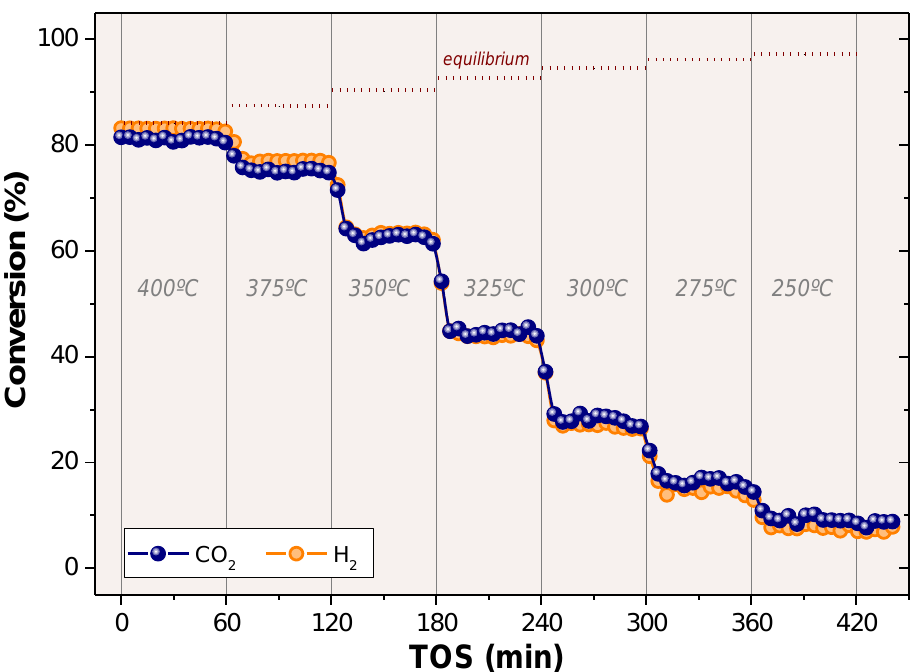
Figure 3. CO 2 and H 2 conversions as a function of temperature and time-on-stream (TOS) for ‘10Ni’ catalyst. Feeding without methane (‘W/O CH 4 ’) . Operating conditions (Table 2): q 0 = 250 STPmL · min − 1 , H 2 :CO 2 = 4:1, and WHSV = 30 × 10 3 (STPmL·g cat −1 ·h −1 ). Table 2. Experimental conditions (base value and studied range) for catalytic activity experiments. Variable (Units) Base Value Studied Range Catalyst (-) 3Ru 10Ni, 3Ru, 7.5Ni – 2.5Fe T (°C) - 400 – 250 * W cat (g)/W inert (g) 0.5/2.0 -